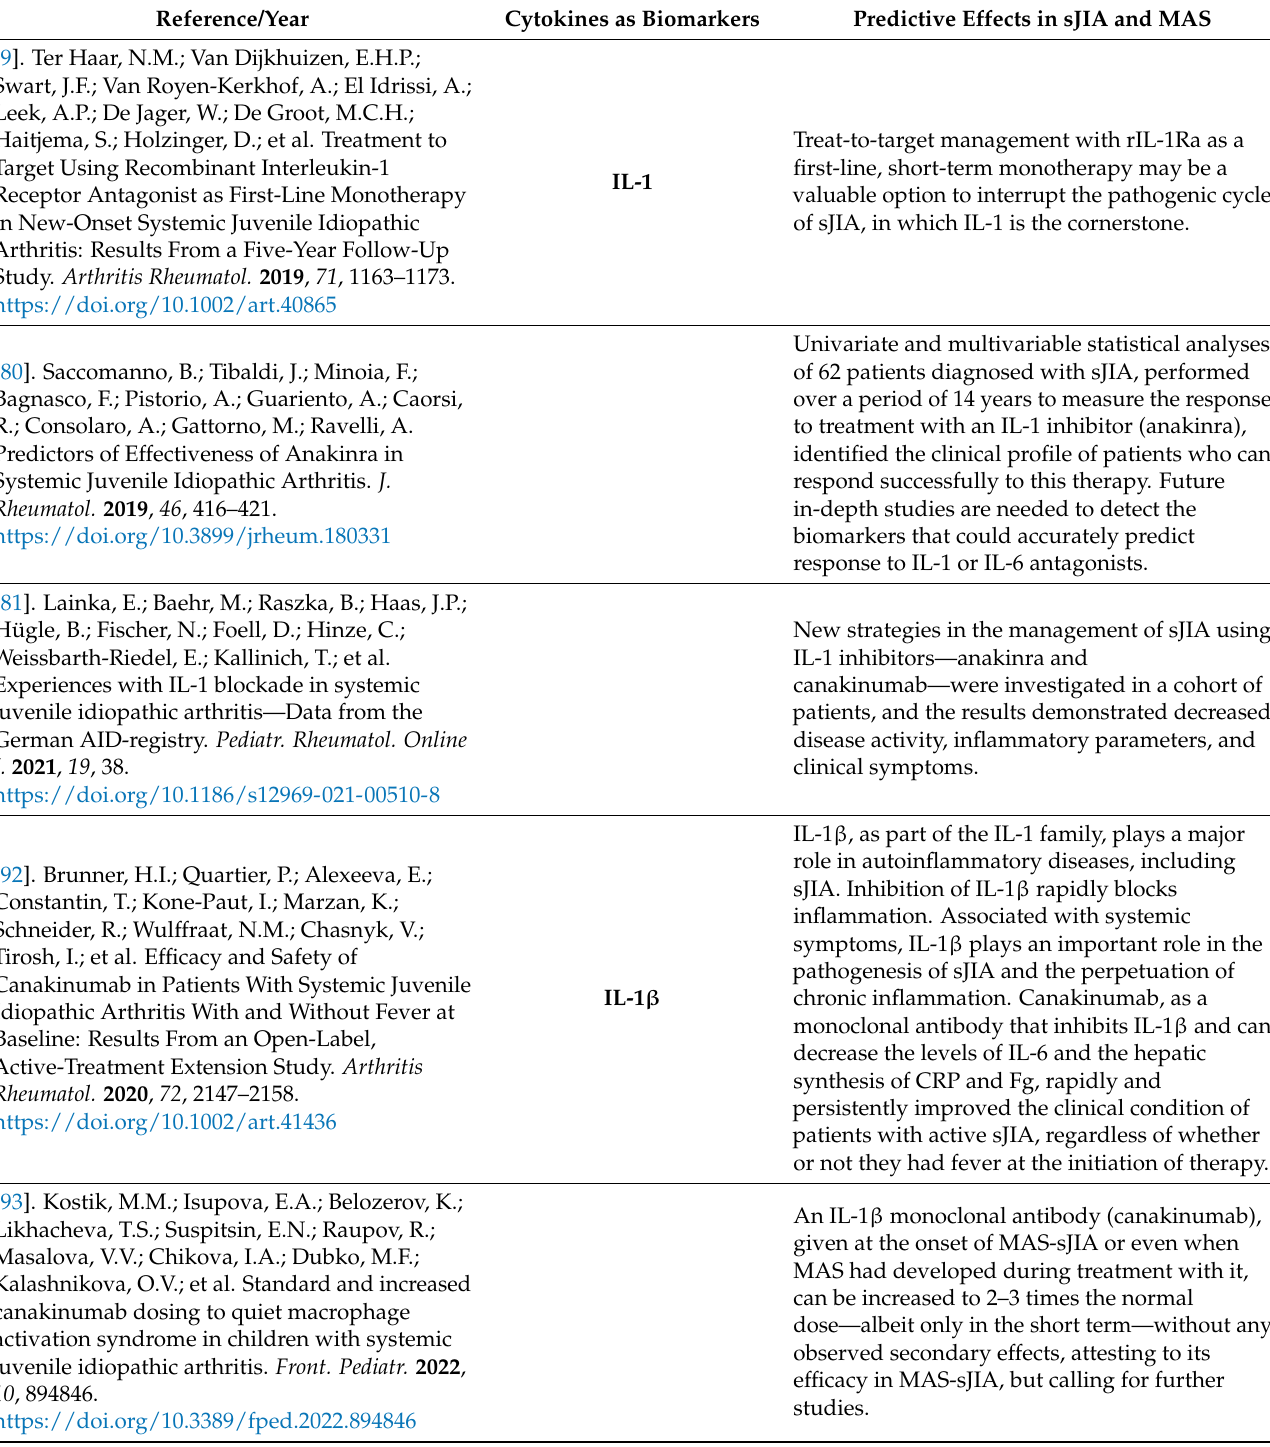
Table 3. Important cytokines as biomarkers for the diagnosis, activity, and prognosis of sJIA and